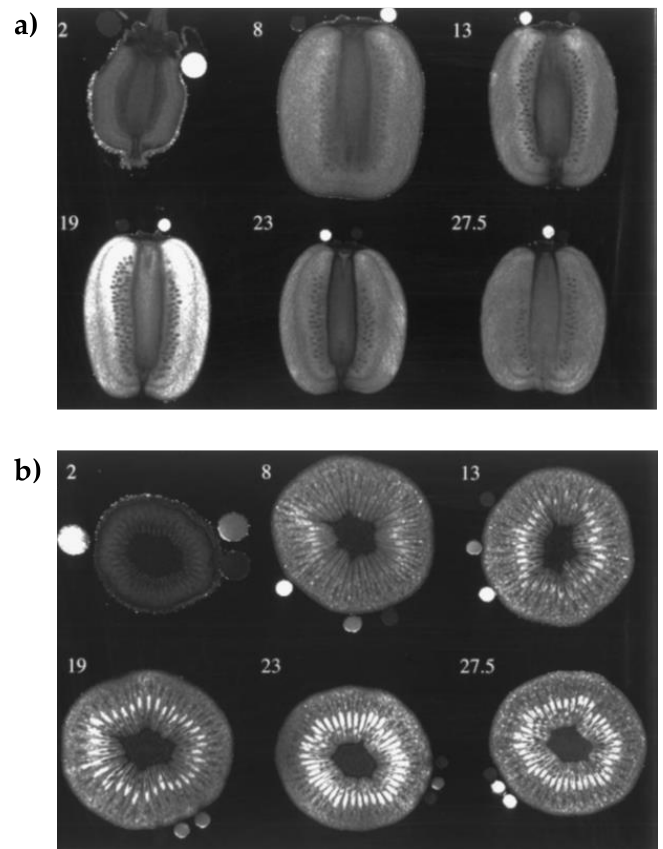
Figure 2. The spin – lattice relaxation (T1) images ( a ) through a longitudinal equatorial plane and spin – spin relaxation (T2) images ( b ) through a transverse equatorial plane of kiwifruit ( A. deliciosa ) during development and ripening. Numbers correspond to weeks from fruitset, with commercial harvest occurring at week 23. Images at 23 and 27.5 weeks are of the same fruit at harvest and after 4.5 weeks ripening. Image resolution varies from 0.12 in the youngest fruit to 0.33 mm in the older samples (256 × 256 pixel data arrays). The circular internal standard tubes (4 mm inner diameter) serve as a scale marker for each panel. Image intensity is based on a continuous grey-scale setting ranging from 0 ms = black to 2500 ms = white (Adapted from [20] with permission from Elsevier, Copyright 1999).